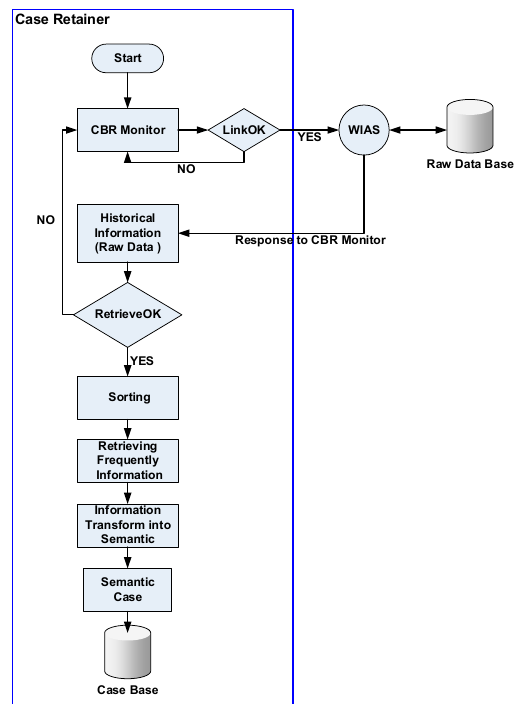
Figure 11. Operational flow of the case retainer.